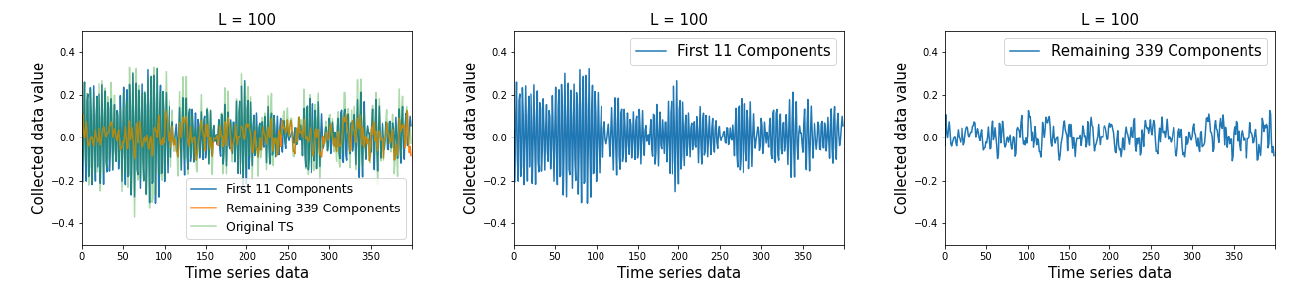
Figure 12. The result of SSA when L is 100, the middle shows first 11 components, the right shows remaining 339 components, the left shows mixture of components.